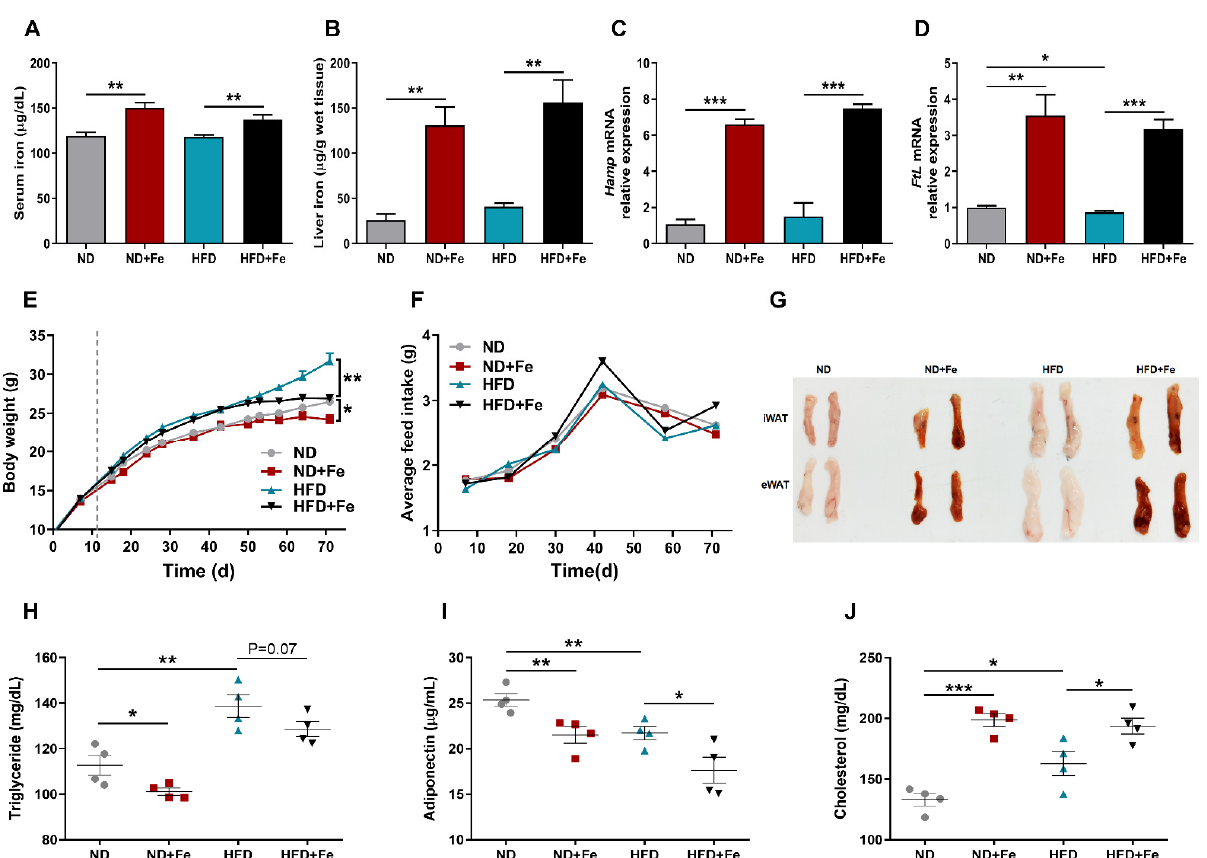
Figure 1. Iron overload protects against HFD-induced obesity. ( A ) Fasting iron content in the serum; ( B ) Hepatic iron content; ( C , D ) Relative gene expression of hepcidin (Hamp) and ferritin L (FtL) in liver samples; ( E ) Body weight; ( F ) Average feed intake; ( G ) Representative images of iWAT and eWAT in mice; ( H ) Fasting serum levels of triglycerides; ( I ) Fasting serum levels of adiponectin; ( J ) Fasting serum levels of cholesterol. ND ( n = 6), ND + Fe ( n = 7), HFD ( n = 7), and HFD + Fe ( n = 8). The values are the means ± SEMs. * p < 0.05, ** p < 0.01, *** p < 0.001. Significant differences between two groups were analyzed with the two-tailed Student’s t test.